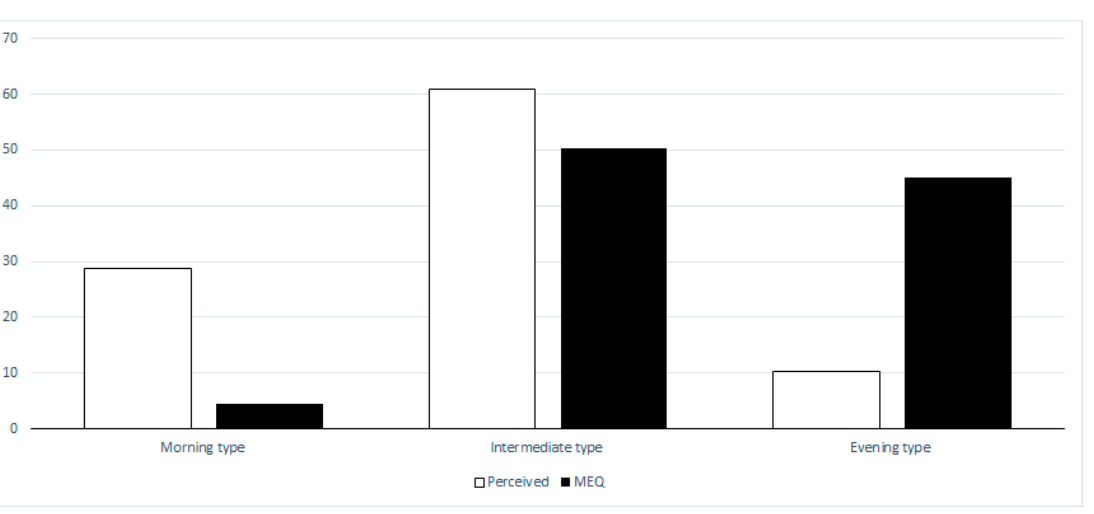
Figure 1. Self-perceived and calculated chronotype distribution of groups. For ease of comparison, the Morningness–Eveningness Questionnaire (MEQ) calculated score was reported considering moderately E-type plus definite E-type as E-type and moderately M-type plus definite M-type as M-type.